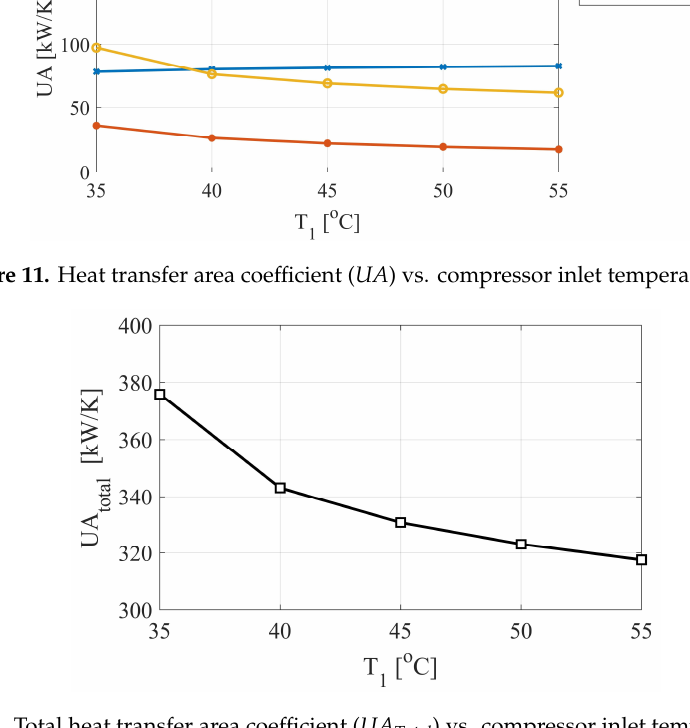
Figure 11. Heat transfer area coefficient ( UA ) vs. compressor inlet temperature ( T 1 ).